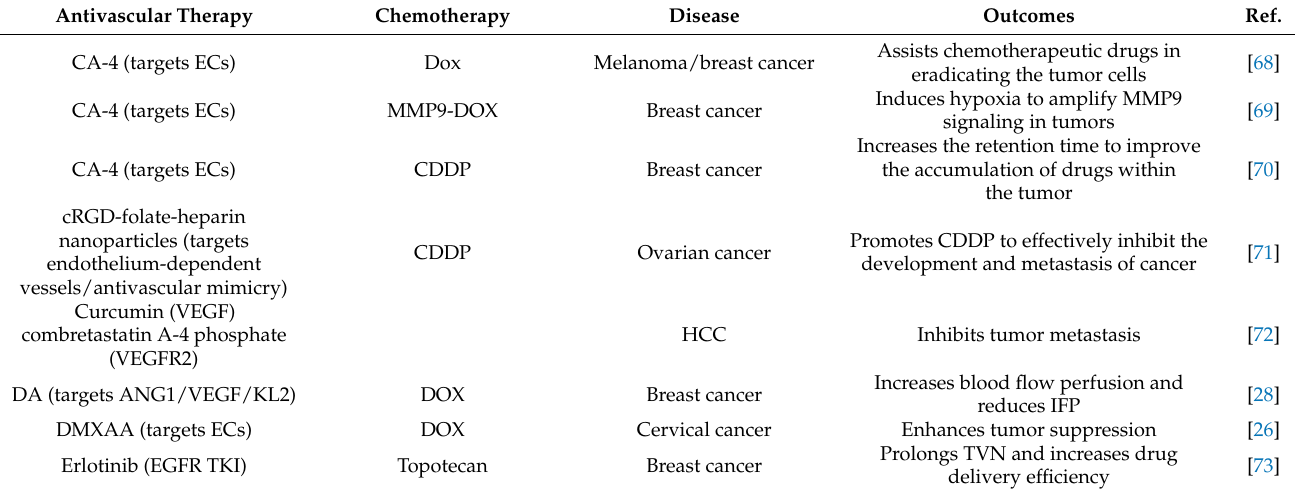
Table 2. Combined therapeutic paradigms of antivascular therapy and